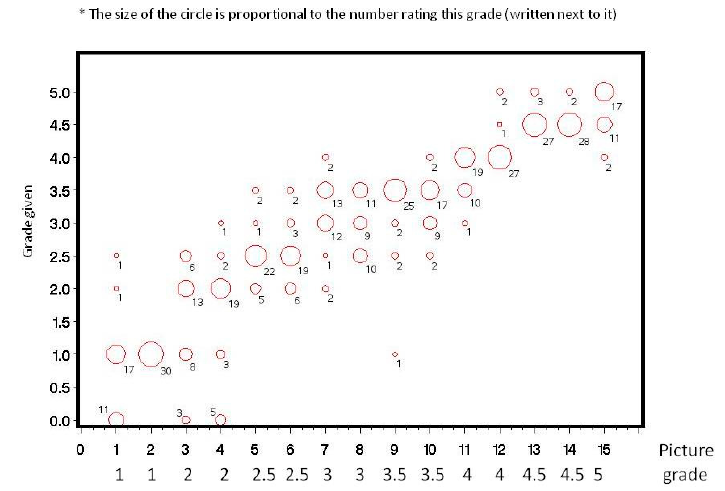
Figure 2. Distribution of 30 ophthalmologists’ grading for the 15 photographs at Time 1.